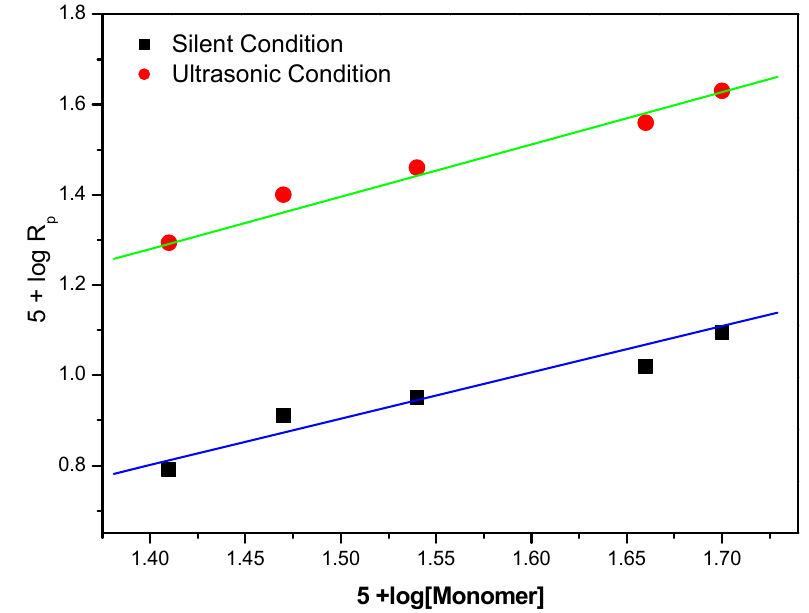
Figure 8. Bi-logarithmic plot illustrating influence of PPS concentration on the R polymerization of MABE under US-MPTC and Silent-MPTC conditions: 2.00 × 10 − 2 mol·dm − 3 of PPS, 1.2 × 10 − 2 mol·dm − 3 of BPMACB, 0.3 mol·dm − 3 of [H + ], 0.1 mol·dm − 3 of [µ], 60 °C